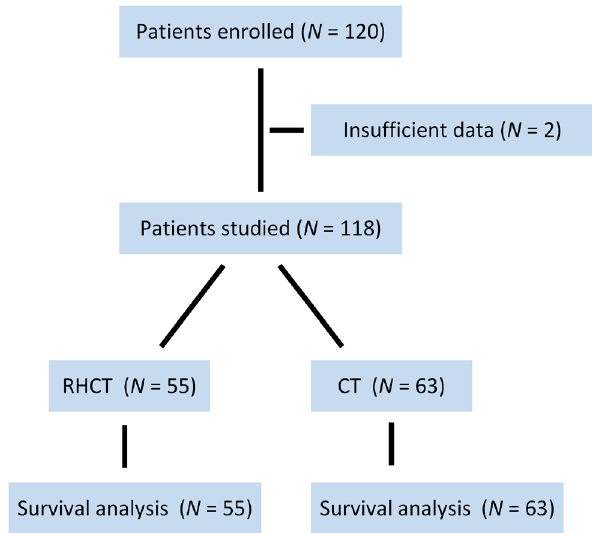
Figure 1: The scheme of this study. RHCT regional hyperthermia with chemotherapy; CT chemotherapy